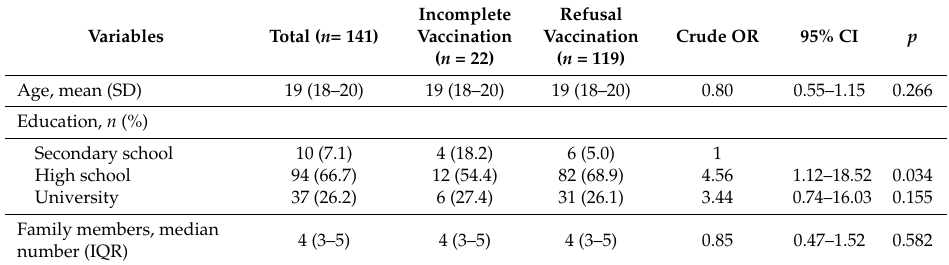
Figure 1. Flow chart for exclusion from the study. Table 1. Demographic characteristics, HPV infection knowledge, and use of gynaecologist services of young adult